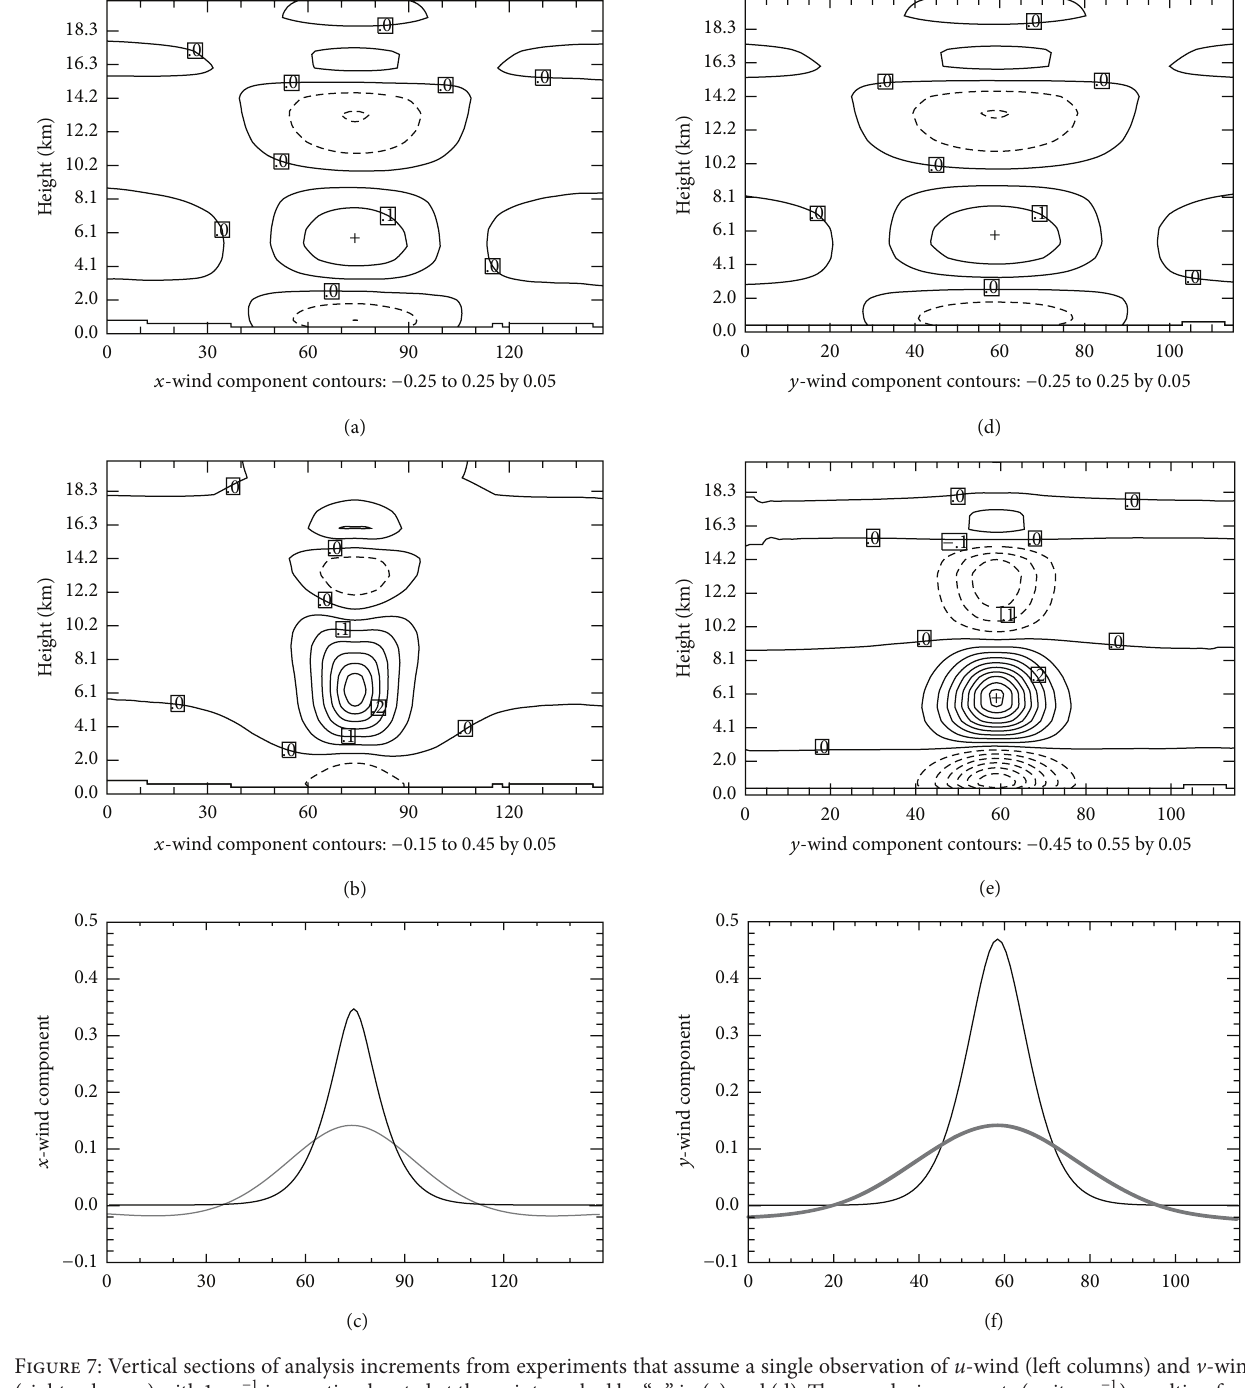
Figure 7: Vertical sections of analysis increments from experiments that assume a single observation of u -wind (left columns) and v -wind (right columns) with 1ms −1 innovation located at the point marked by “+” in (a) and (d). The 𝑢 and V increments (unit: ms −1 ) resulting from the analyses that use 𝜓 and 𝜒 as momentum control variables are shown in (a) and (d), respectively, and from the direct use of 𝑢 and V as control variables that are shown in (b) and (e), respectively. The magnitudes of 𝑢 and V increments on the observation level (6km) are plotted as a function of x - and y -grid points. The horizontal grid spacing is